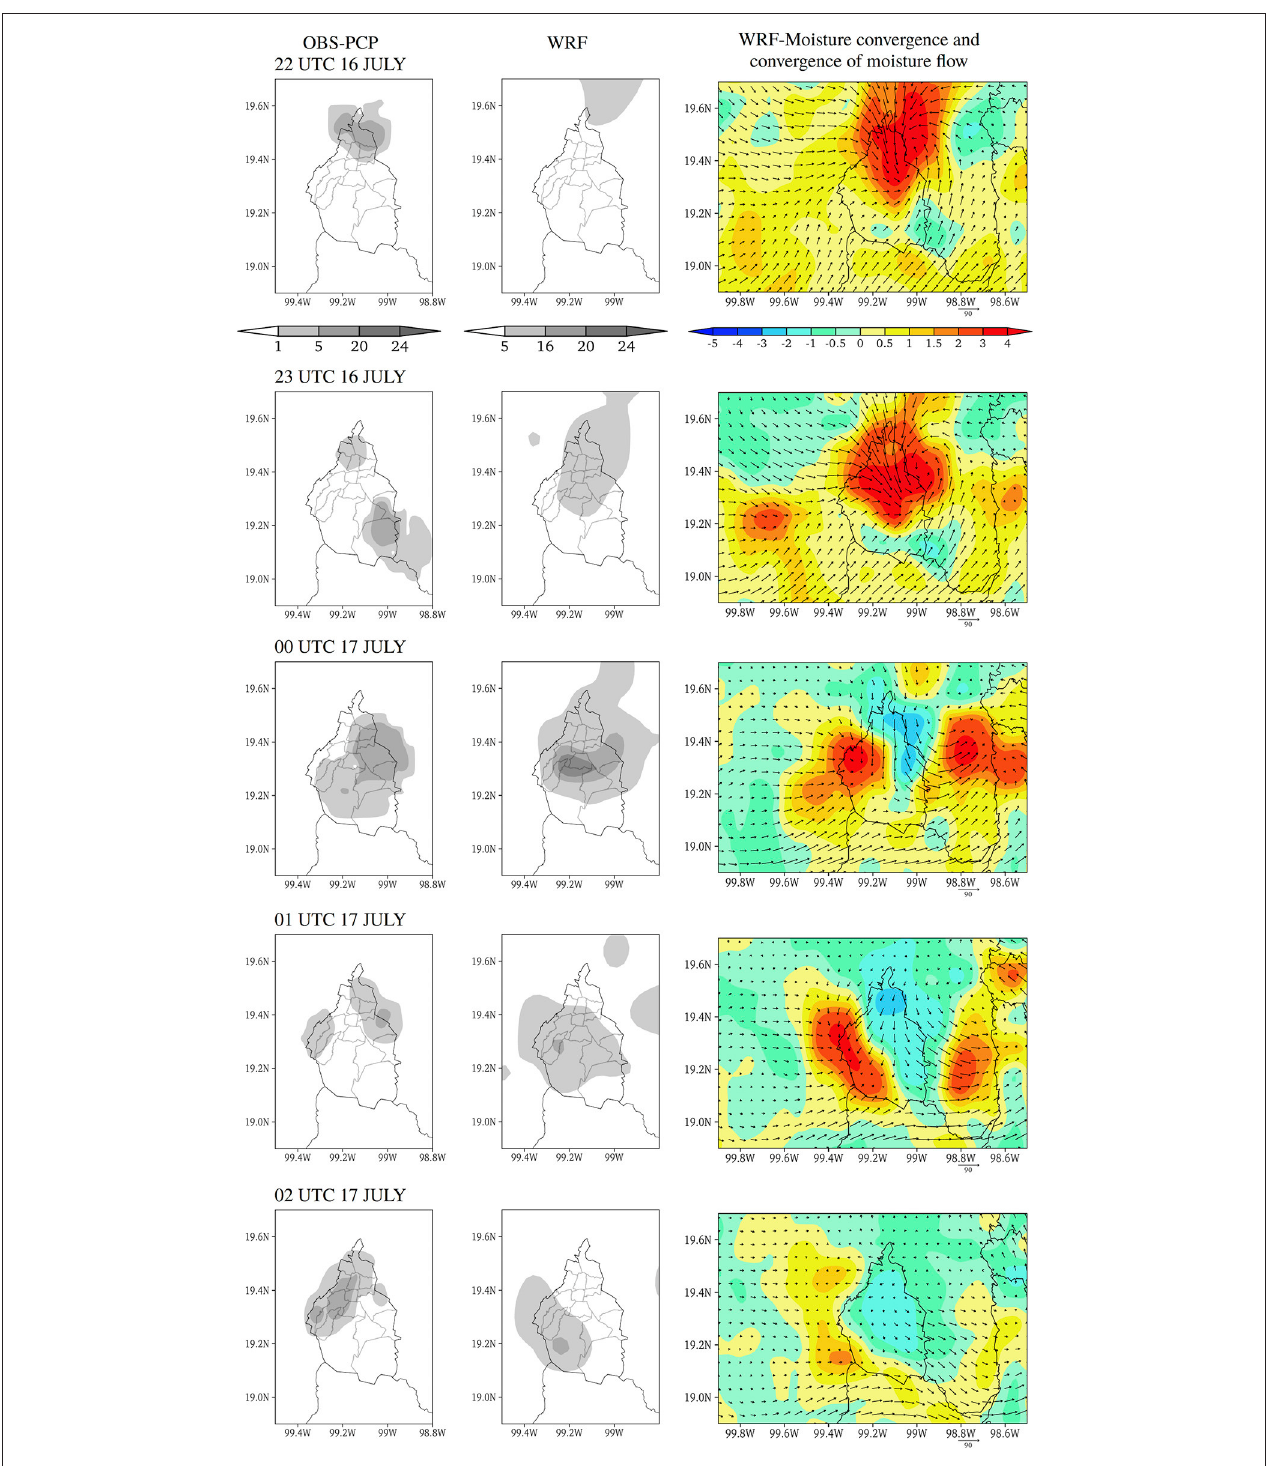
FIGURE 12 | Hourly precipitation between 22:00 UTC 16 July and 02:00 UTC 17 July 2014: (left) observed; (center) forecast; (right) shaded area, moisture convergence (kg/kg/s) and surface to 650mb convergence of moisture flow (kg/m/s).